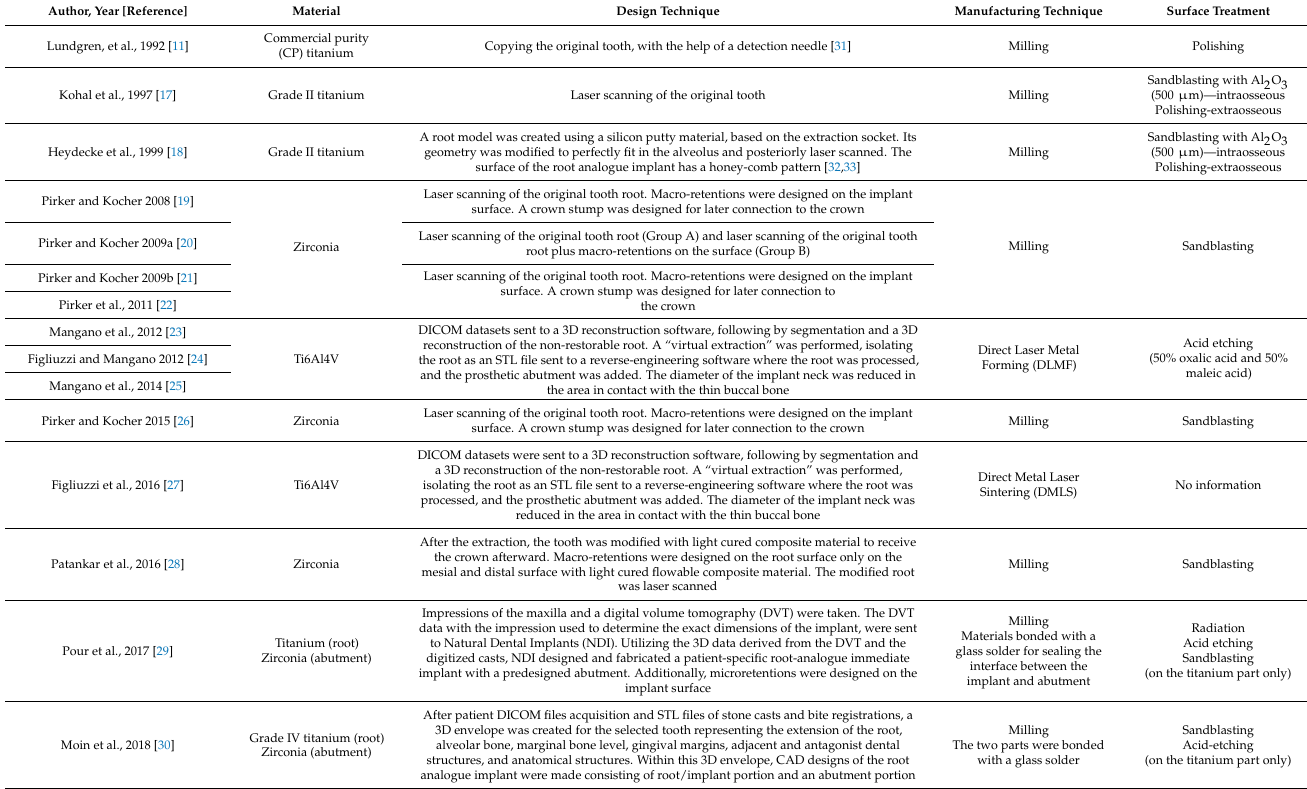
Table 2. Summary of the selected articles: implant material, design and manufacturing techniques and implant surface